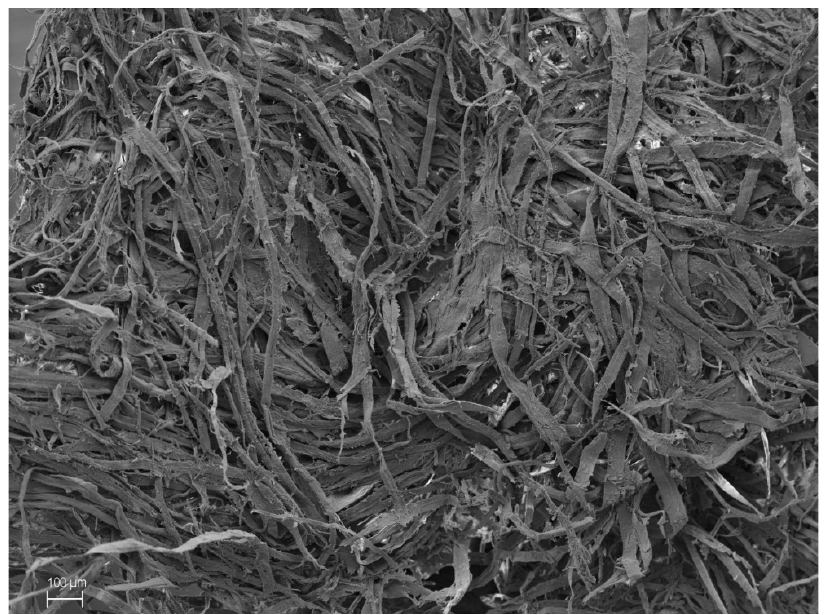
Figure 2. Image of the cellulose fibers of the Paper Industry obtained with the Scanning Electron Microscope in the secondary option.